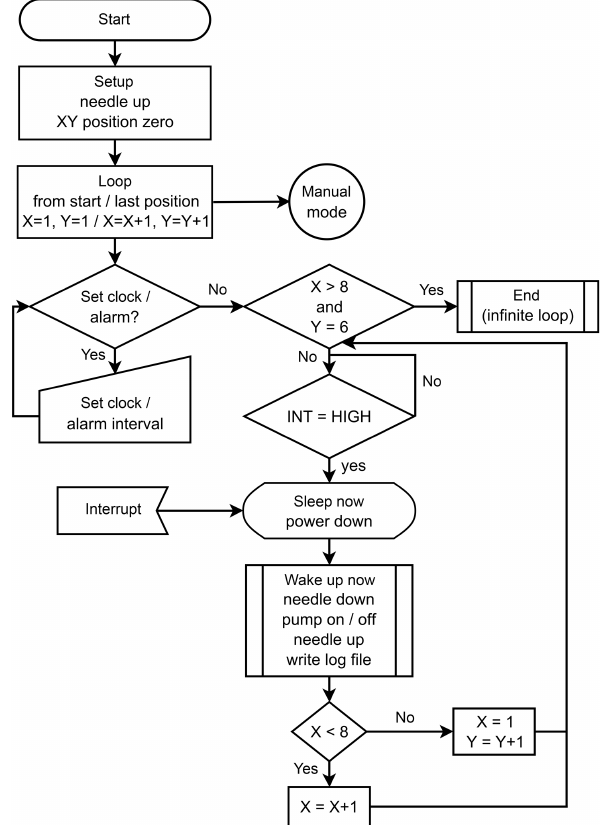
Figure 3. Flowchart illustrating the autosampler’s operation for a set-up comprising 48 sample vials in total, arranged in lines ( x di- rection) of 8 and columns ( y direction) of 6 vials, respectively. Once the last sample has been collected, the program enters an infinite loop and waits for input from the operator.